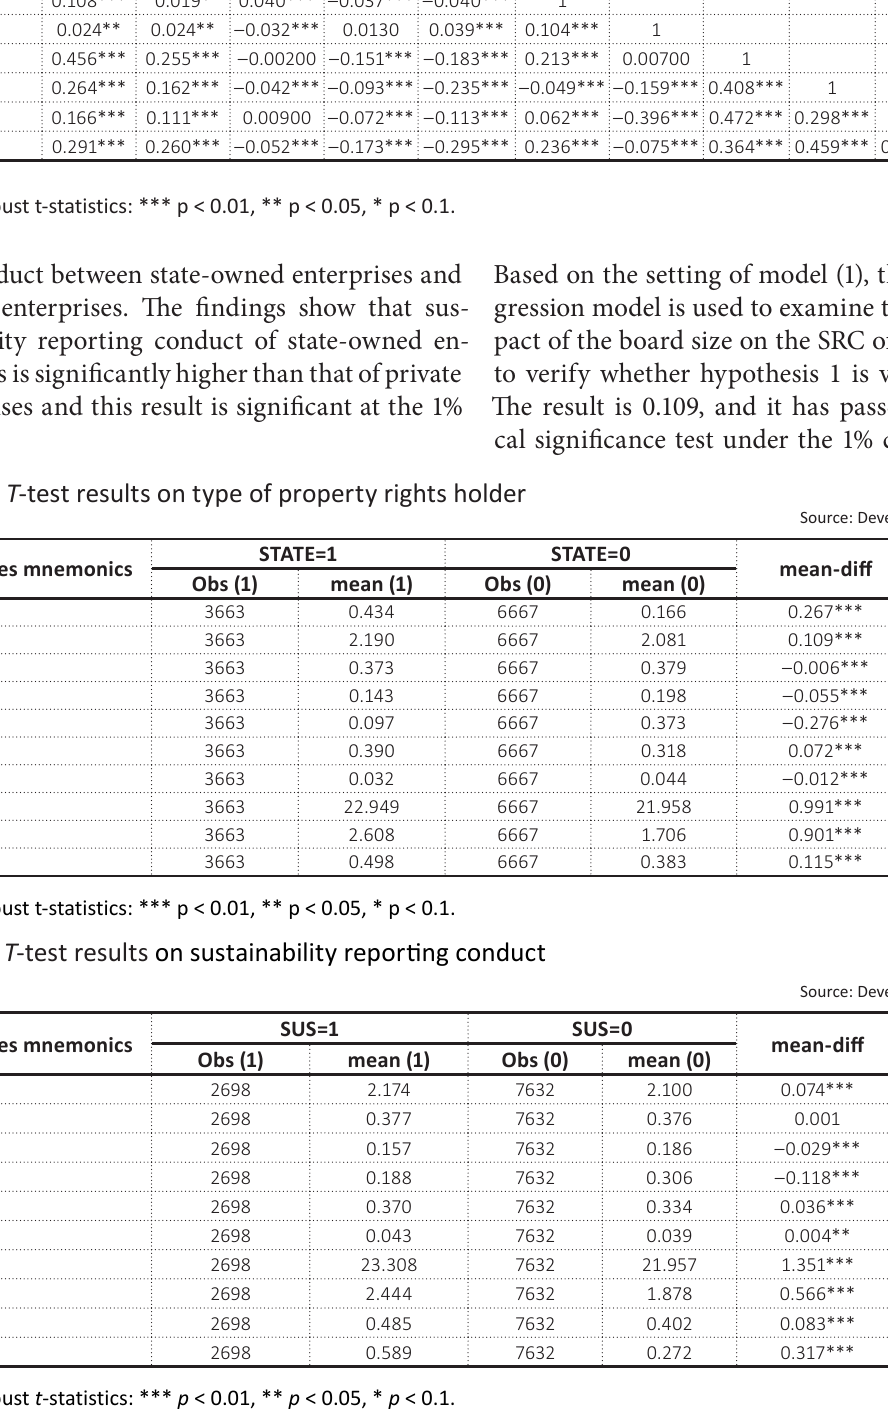
Source: Developed by the